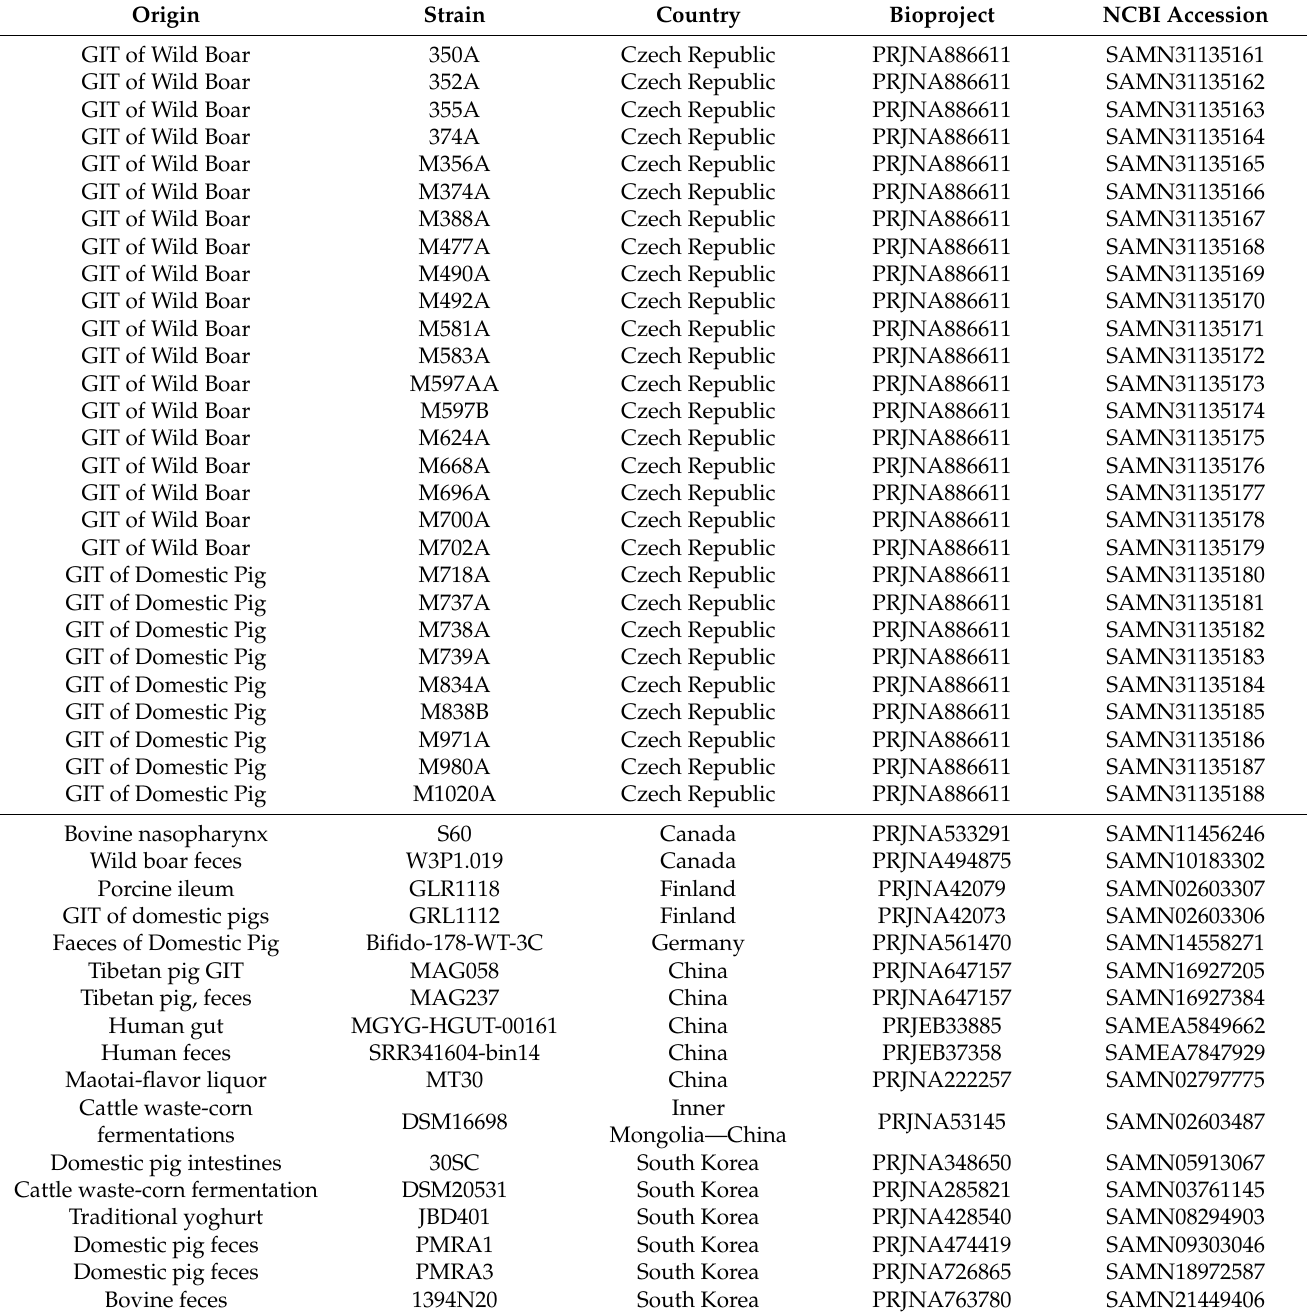
Table 1. Newly sequenced genomes and NCBI genomes of L. amylovorus